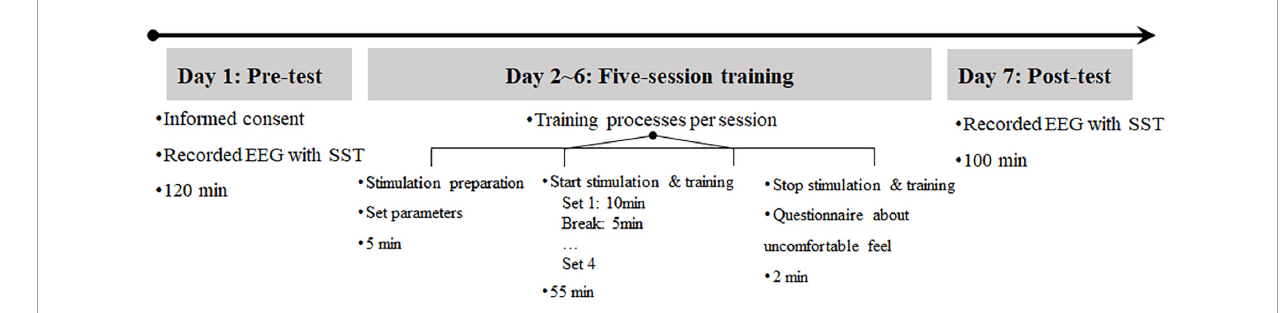
FIGURE1 Overview of the experimental procedure and timeline in the study.